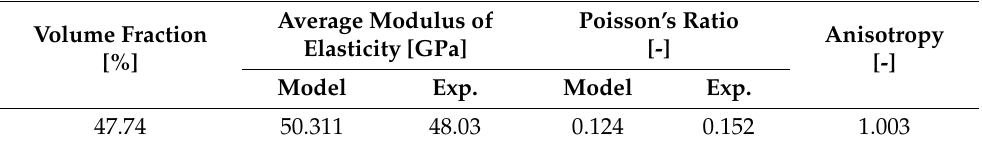
Table 6. Homogenised elastic properties of the synthetic concrete sample in comparison with experimental data obtained from a uniaxial compression